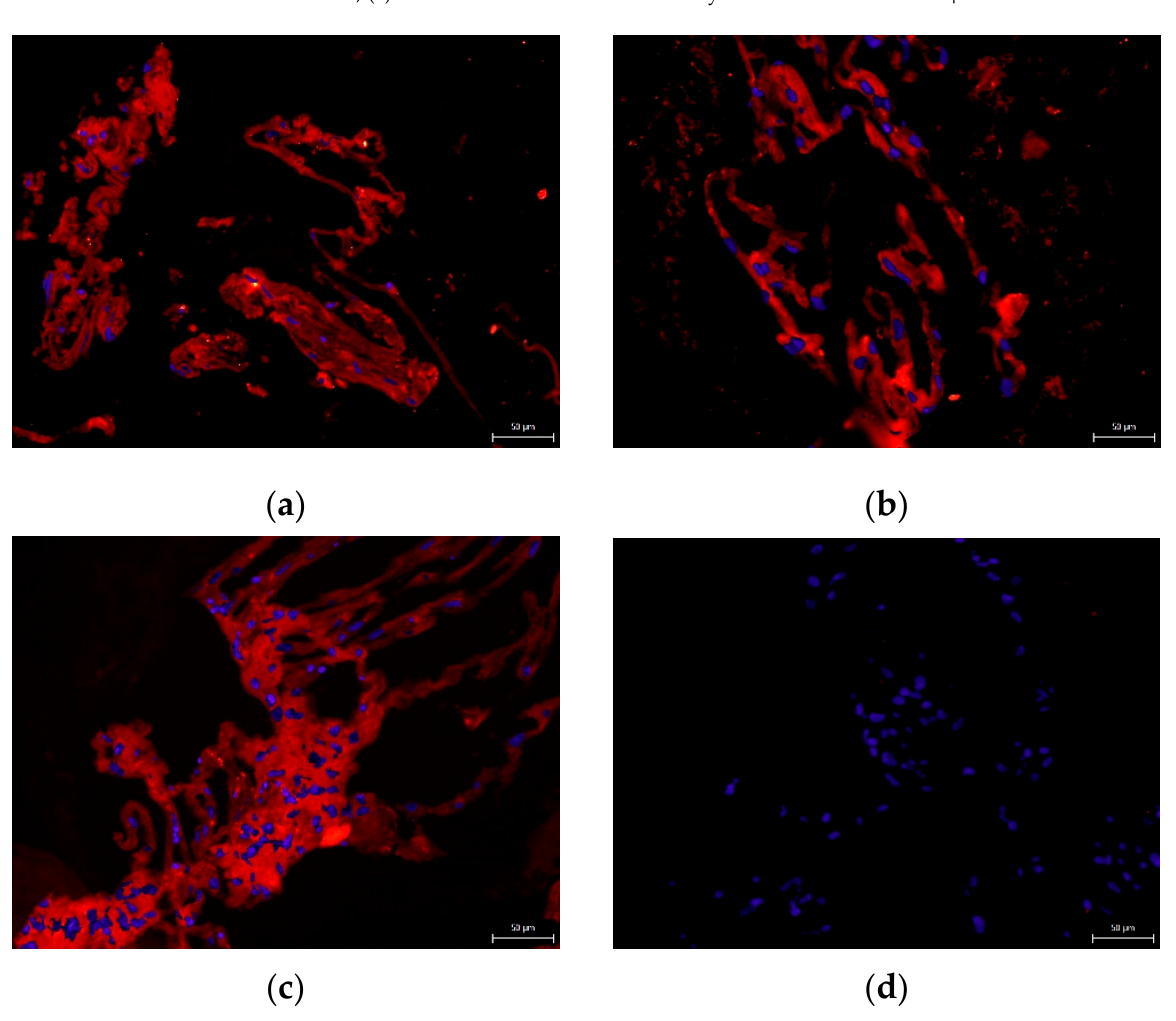
Figure 7. Immunocytochemical detection of type II collagen in the extracellular chondrogenic mass of the DPSCs after 3-week cultivation in a chondrogenic differentiation medium. Type II collagen shows up as fluorescent red, and stem cell nuclei fluorescent blue: ( a ) 10% DMSO cryomedium; ( b ) 3% DMSO cryomedium; ( c ) 3% DMSO + 0.1% HMW-HA cryomedium; ( d ) non-differentiated DPSCs. Scale bar 50 µm.